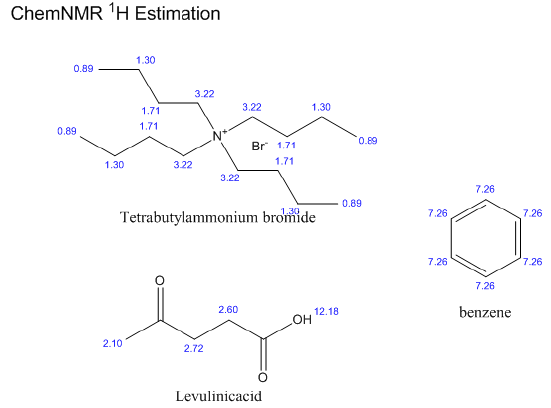
Figure 19. Chemical shift values of intramolecular hydrogen atoms of TBAB, LA, and benzene estimated by ChemDraw.